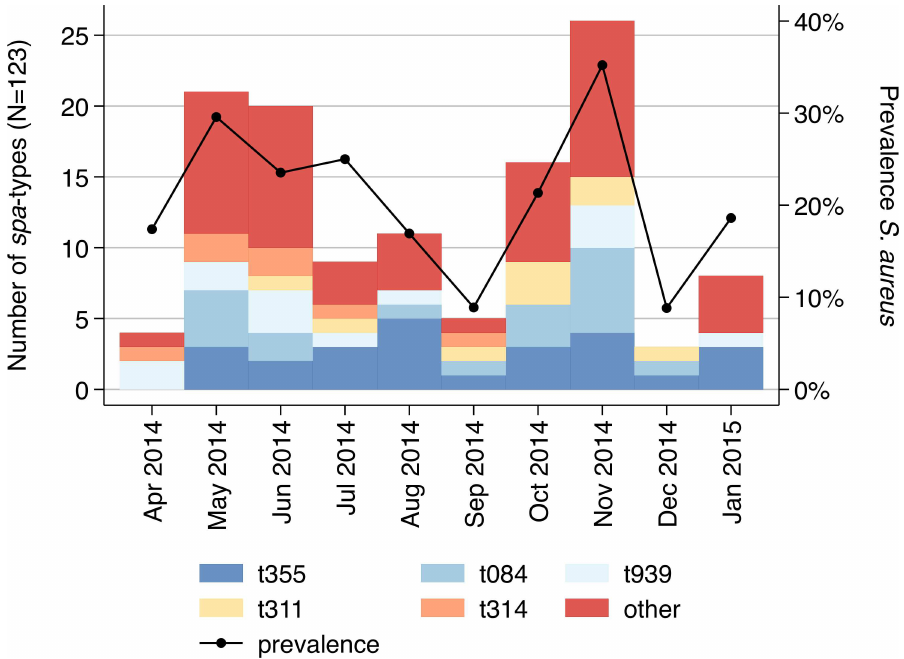
Fig 2. Temporal distribution of spa -types. Distributionof spa -types(n = 123) by month. The black line indicatesthe Staphylococcus aureus prevalence(n =